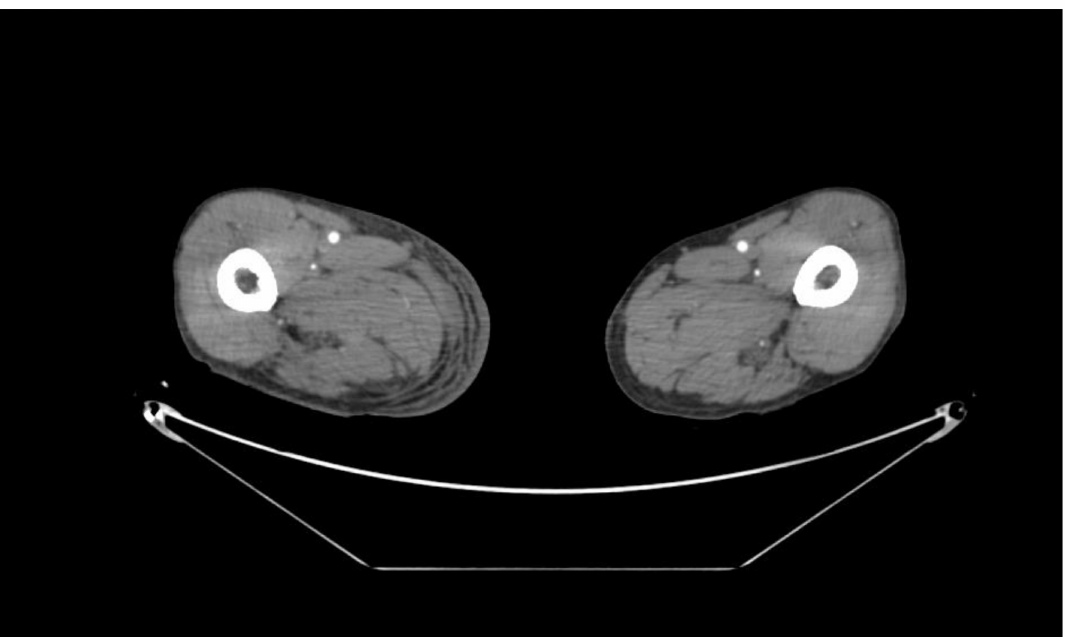
Figure 2. Contrast computed tomography of the bilateral thigh revealed hematoma of the right thigh and did not show any